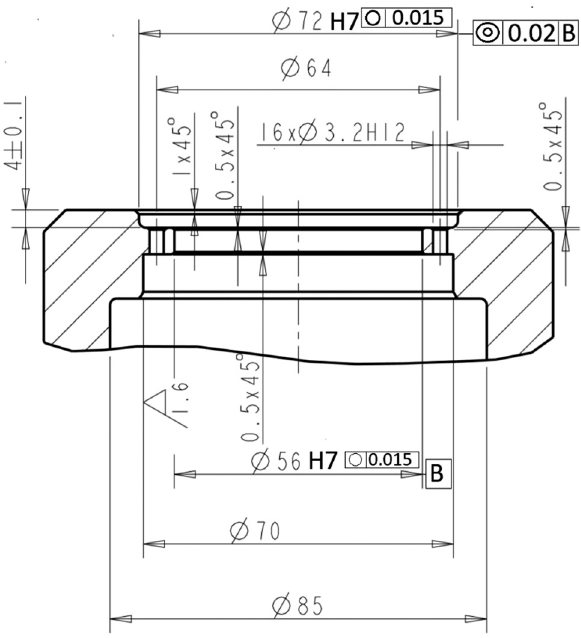
Figure 3: Production drawing of a robot base.